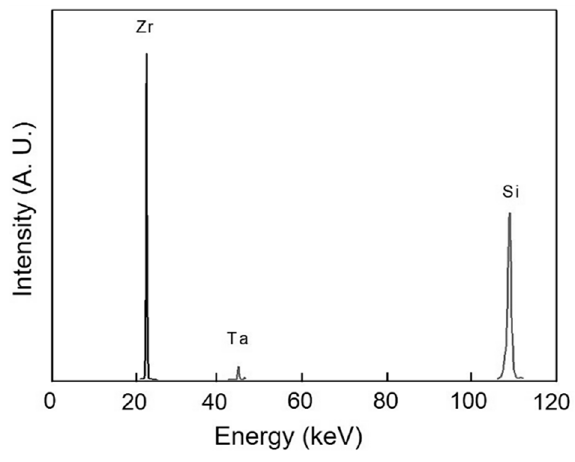
Figure 5. X-ray fluorescence (XRF) spectroscopy of ZrB 2 –SiC–TaC.